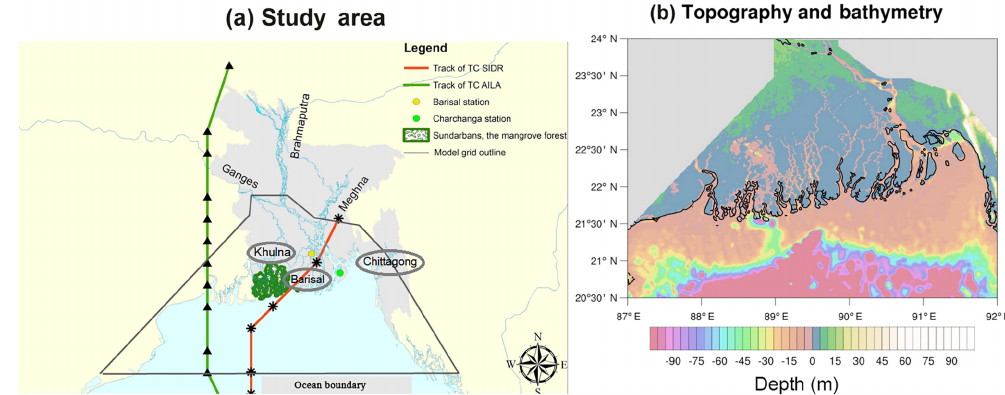
Figure 1. (a) Map of the study area for this work. The red and green lines represent the tracks of TC Sidr and TC Aila respectively. The area marked in green indicates the Sundarban mangrove forest region. Locations of the Ganges, Brahmaputra and Meghna rivers are shown on the map. Khulna, Barisal and Chittagong, which are landfall locations for the historical TCs used for ensemble projection, are shown inside a circular box on the map. Two circles over the study area are the observation stations of Bangladesh Inland Water Transport Authority (BIWTA). The black-coloured outline shows the extent of the model grid over the region. (b) Topography and bathymetry of the model domain. Negative depth values represent water bodies (ocean and rivers) and positive depth values areas represent